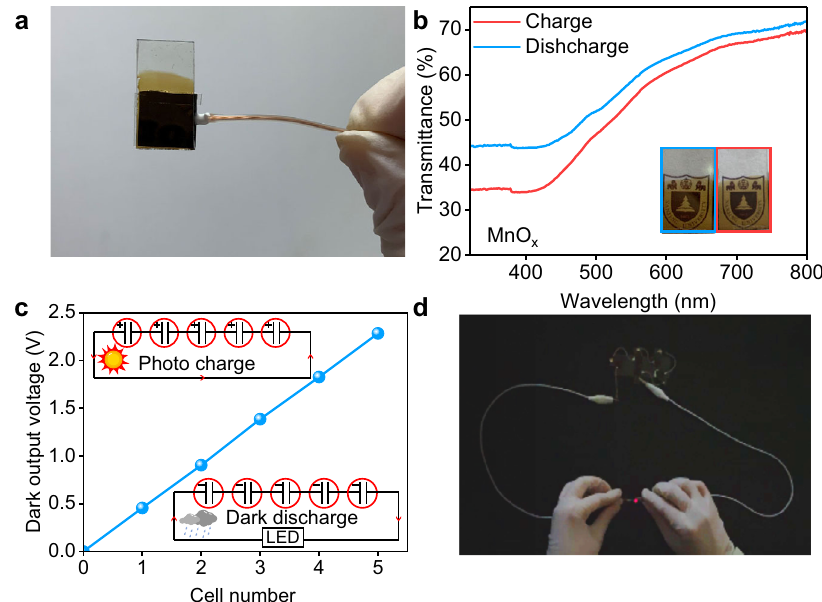
Fig. 4 Demonstrations of Faradaic junction solar rechargeable devices. a A picture of a portable Si/CoO x /KBi (aq) /MnO x device with an effective area of about 0.8 cm 2 . b UV-Vis spectra of a MnO x counter electrode after charge and discharge in the dark. c Dark output voltages of fi ve Si/CoO x /KBi (aq) /MnO x devices connected in series after photo charge. Inset picture: electrical connection modes of fi ve devices under photo charge and dark discharge. d Photograph of fi ve Si/CoO x /KBi (aq) /MnO x devices connected in series to power a LED after photo